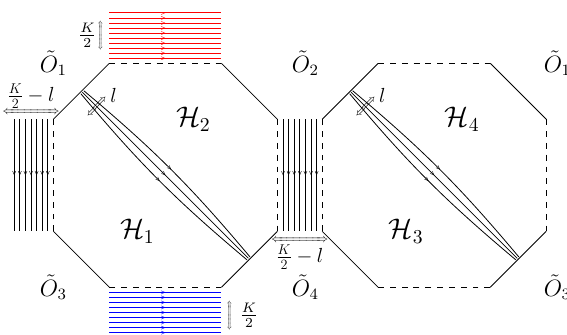
Figure 9 . At a given loop order for su(cid:14)ciently large K and small bridge l we have two decouple K octagons: and . When l , then the small bridge is K 2 H 1 [ H 2 H 3 [ H 4 (cid:24) octagons are and H 2 [ H 3 H 1 [ H 4